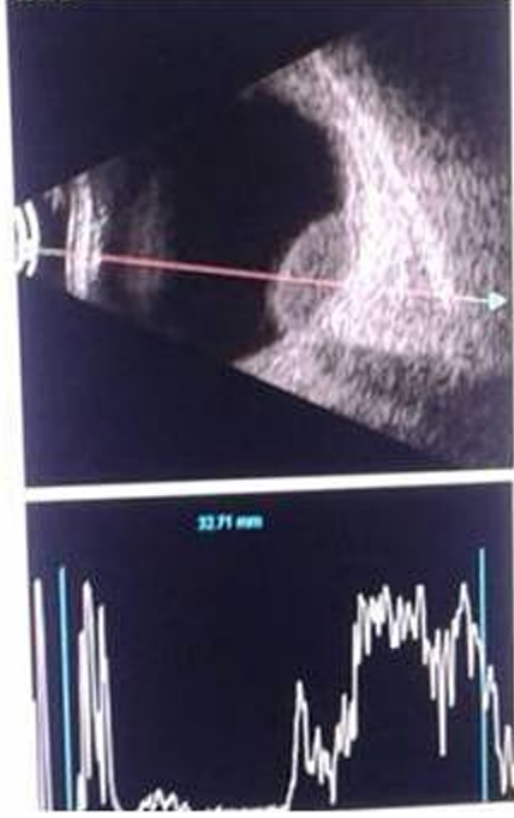
Figure 3: Ultrasonography shows a mass lesion of uniform echogenecity and low internal